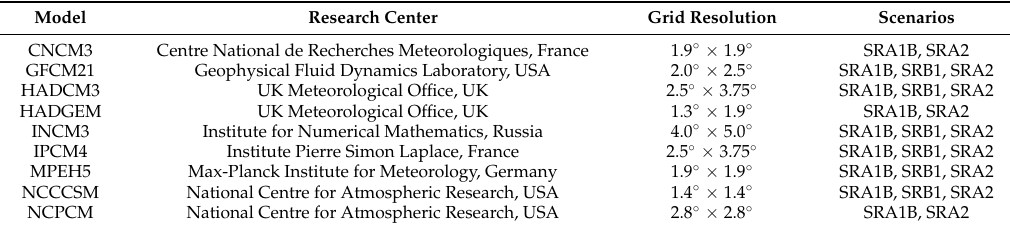
Table 1. Global climate models applied in the